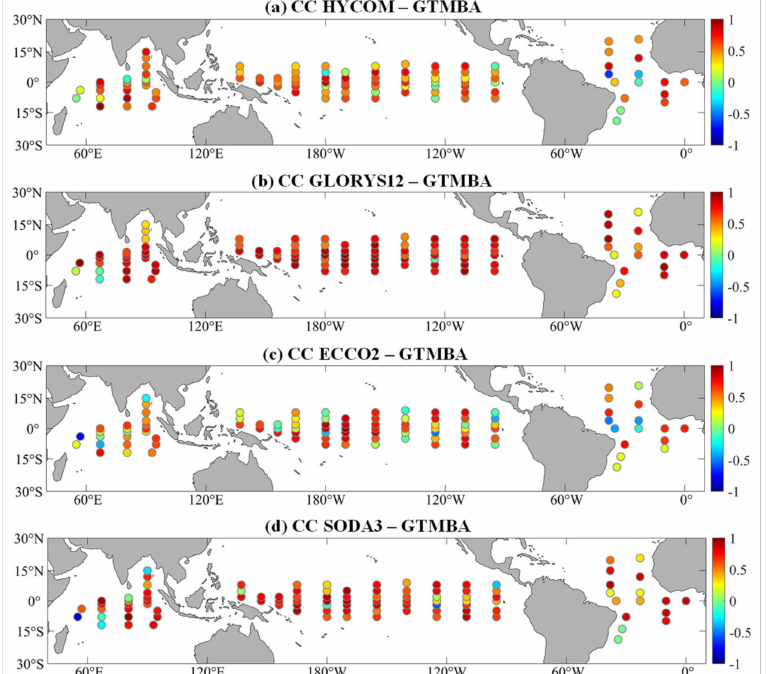
Figure 10. Comparison of CC values between five SSS reanalysis products with respect to the salinity data measured by GTMBA buoys at 1 m depth at weekly scale. The time range is from 1 January 2015 to 31 December 2015.